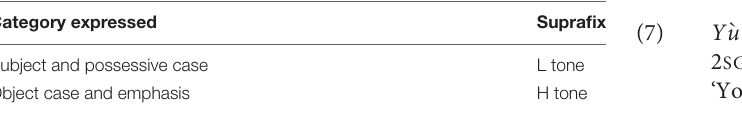
TABLE 3 | Suprafixation with personal pronouns in